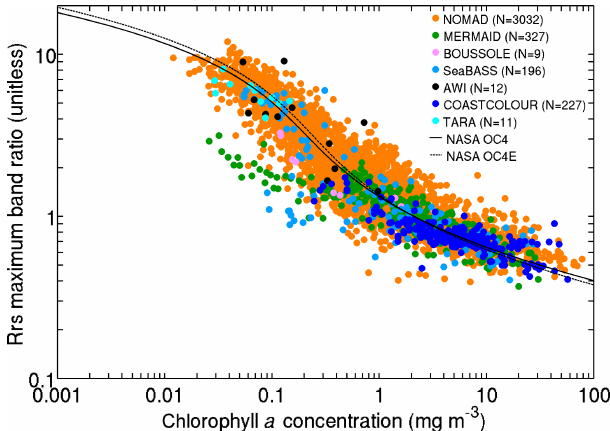
Figure 11. A remote-sensing reflectance maximum band ratio (as defined in text) ([443,490,510] / 555 or [443,490,510] / 560 if 555 not available) as a function of chlorophyll a concentration. All chlorophyll data were considered, but for a given station, HPLC data were selected if available. Data within 2nm of the wave- lengths were used. For reference, the solid and dotted lines show the NASA OC4 and OC4E v6 standard algorithms, respectively (https://oceancolor.gsfc.nasa.gov/atbd/chlor_a/, last access: 10 July 2019). The total number of points was 3814, of which 79% were from